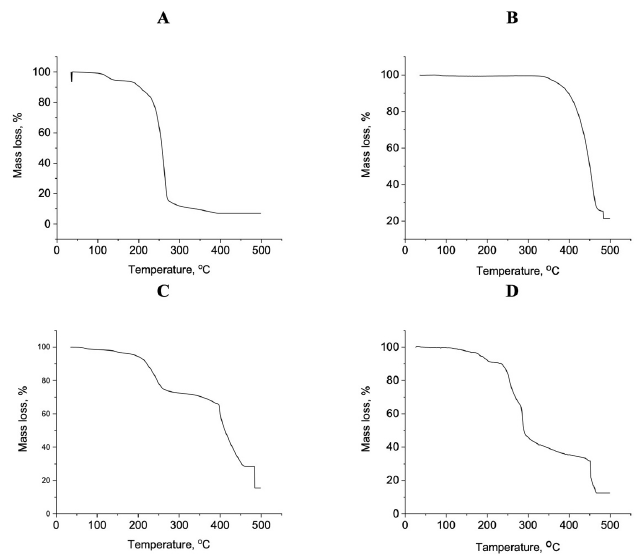
Figure 6. TGA curves of ( A ): Mg(II), ( B ): Ca(II), ( C ): Zn(II), and ( D ): Fe(III)–pip complexes. Table 4. TGA data for the Mg(II), Ca(II), Zn(II), and Fe(III)–pip complexes.